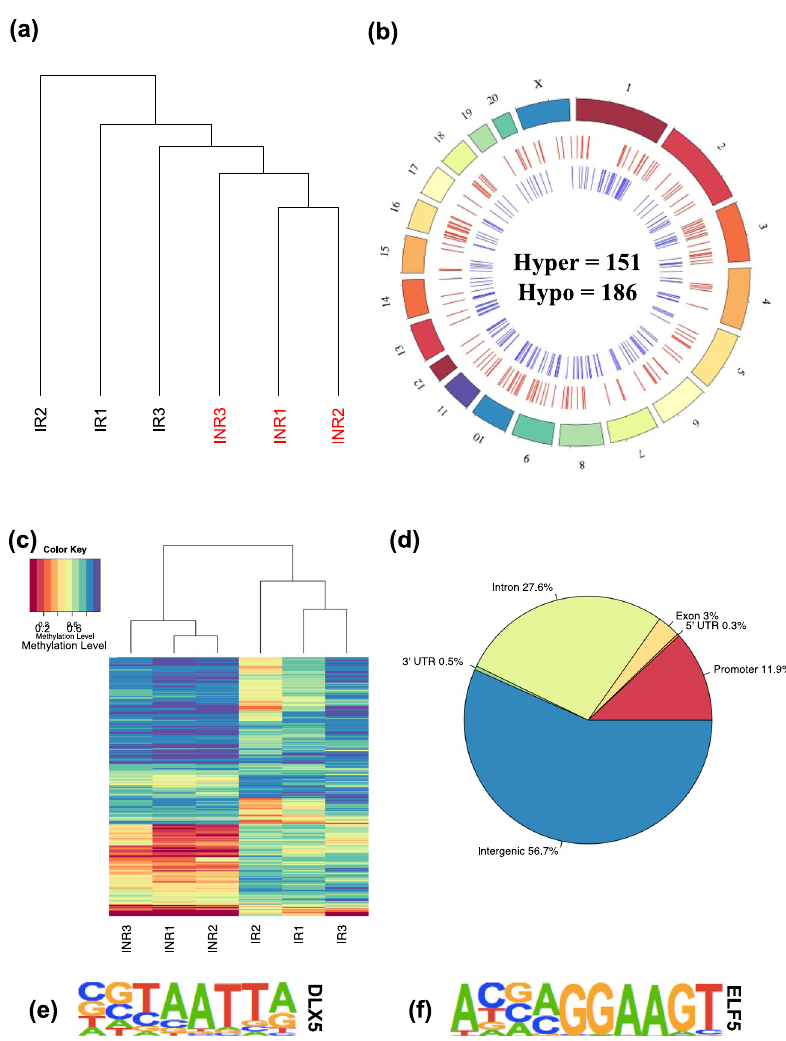
Fig. 3 DNA methylation levels are linked to regeneration following injury. a Unsupervised hierarchical clustering using global levels of DNA methylation levels distinguish injured/regenerated (IR) ( N = 12 retinas) (black) from injured/non-regenerated (INR) ( N = 12 retinas) RGCs (red). b A circos plot depicts the genome-wide relative location of regeneration-associated hyper DMRs ( N = 151; red; middle circle) and hypo DMRs ( N = 186; blue; inner circle) on each chromosome (outer circle) across the genome. c Unsupervised hierarchical clustering using the DNA methylation data from only the CpGs located in the 337 DMRs comparing IR against INR RGCs. Corresponding heatmap shows the level of methylation at each CpG from each RGC group. Low levels of DNA methylation (red) and high levels of DNA methylation (purple) are depicted. d A pie chart shows the proportion of DMR locations relative to standard genic structures. e , f Weblogos display the motif of a representative transcription factor signi fi cantly enriched in hypermethylated (DLX5) and hypomethylated (ELF5)